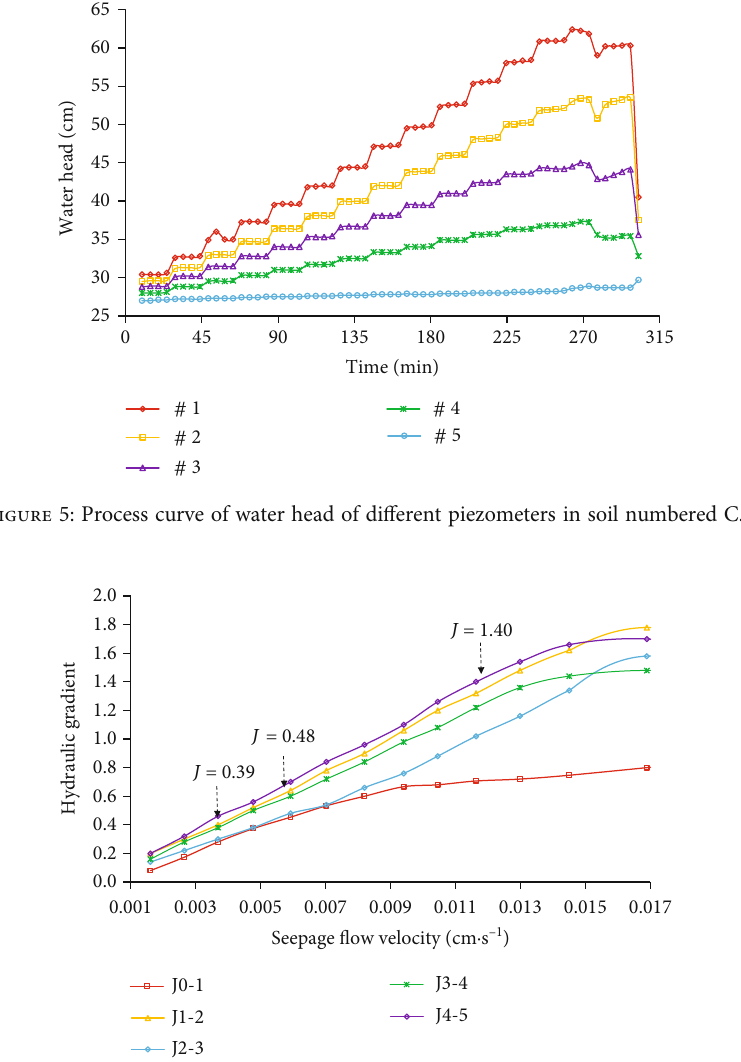
Figure 6: Process curve between hydraulic gradient and seepage fl ow velocity of di ff erent parts in soil numbered C.